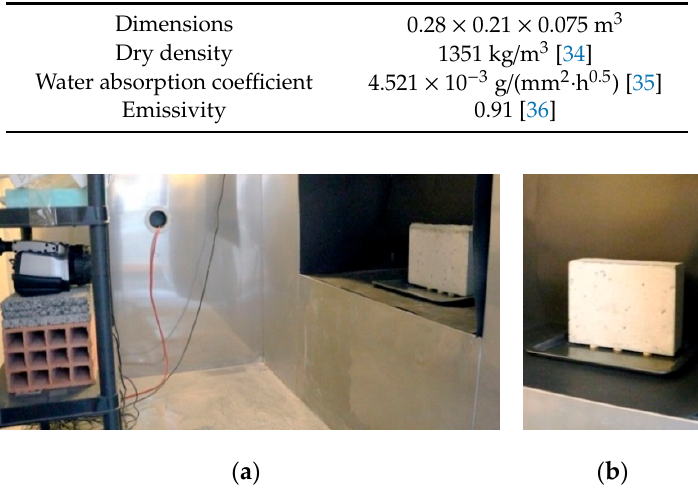
Figure 1. ( a ) Test set-up; ( b ) partial humidification of the specimen by the bottom.